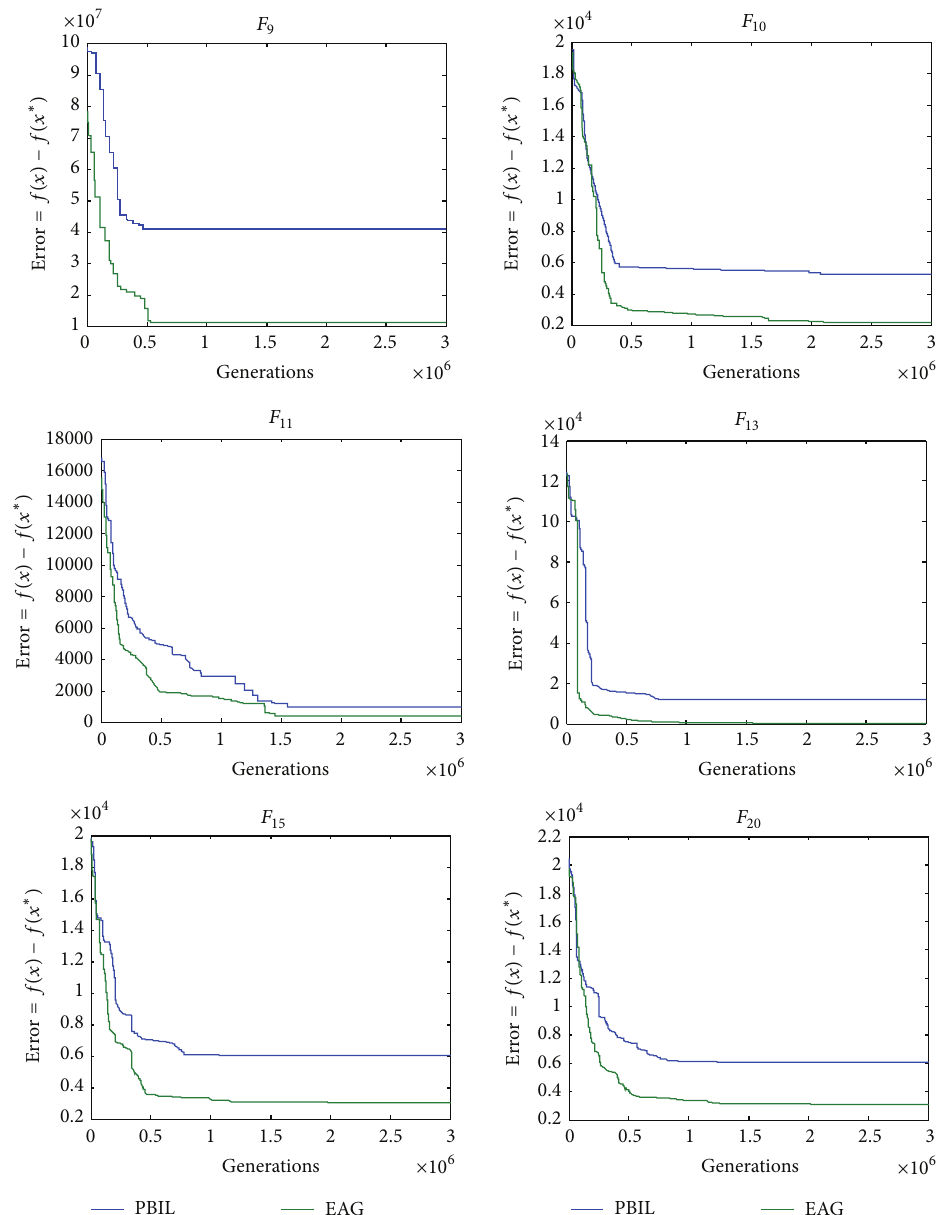
Figure 1: Convergence graph of PBIL and EAG on the select functions: 𝐹 1 , 𝐹 2 , 𝐹 3 , 𝐹 4 , 𝐹 5 , 𝐹 6 , 𝐹 7 , 𝐹 8 , 𝐹 9 , 𝐹 10 , 𝐹 11 , 𝐹 13 , 𝐹 15 , and 𝐹 20 .